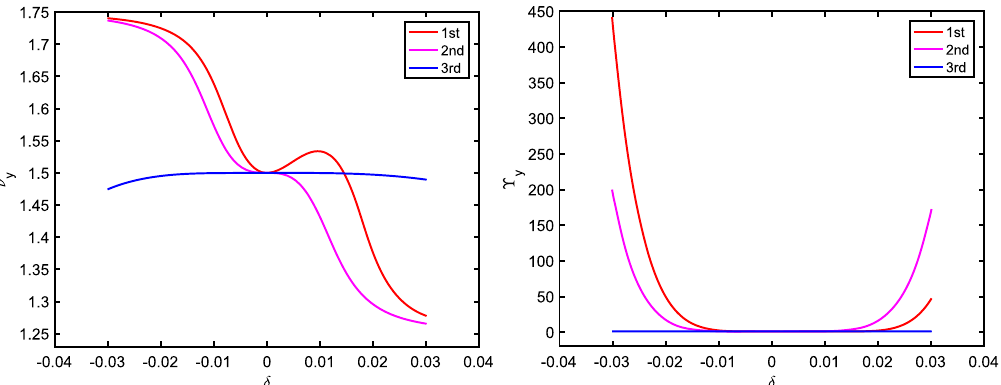
FIG. 10. Chromatic bandwidth of the final focus system with different order of corrections shown on (left) the vertical phase advance in unit of 2 π and (right) the Sands ’ mismatch parameter ϒ .